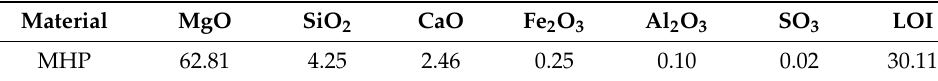
Table 2. Composition of used magnesium hydroxide powder (%).